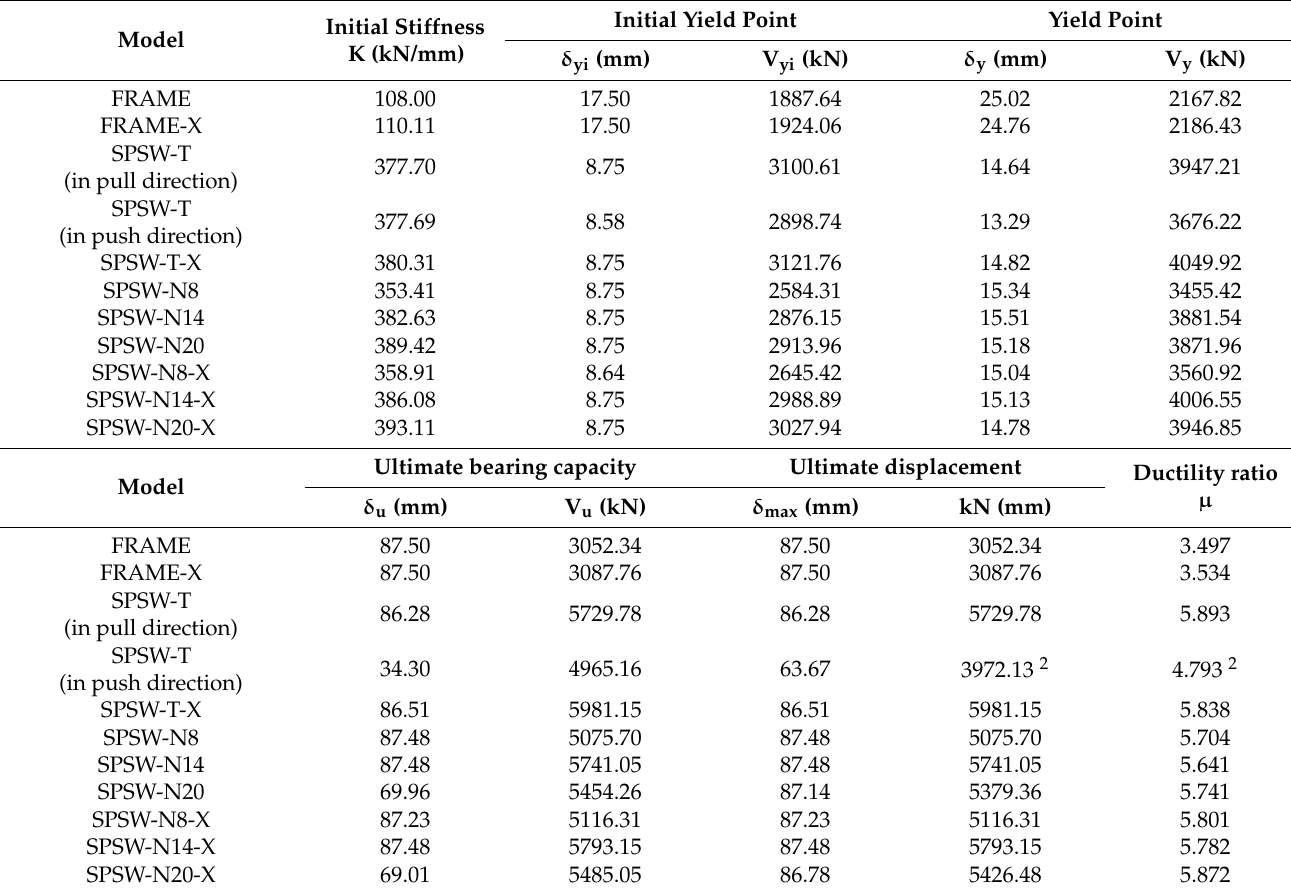
connections and frames 1